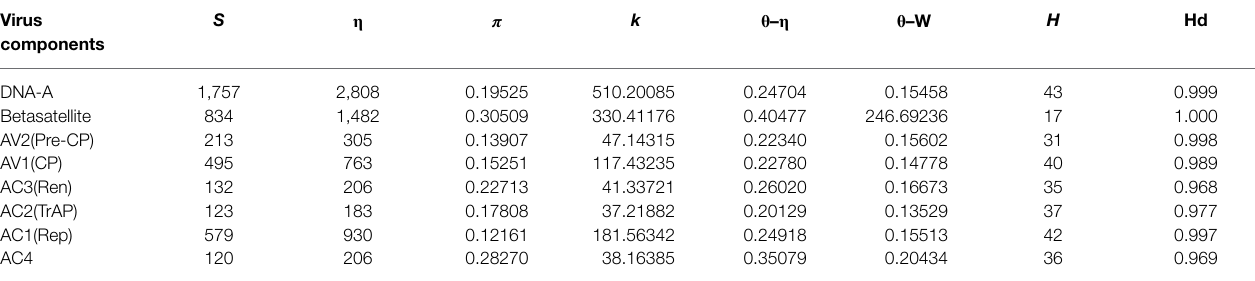
TABLE 6 | Estimation of the Genetic diversity of begomoviruses (DNA-A), ORFs, and betasatellites associated with PaLCD in India. Virus